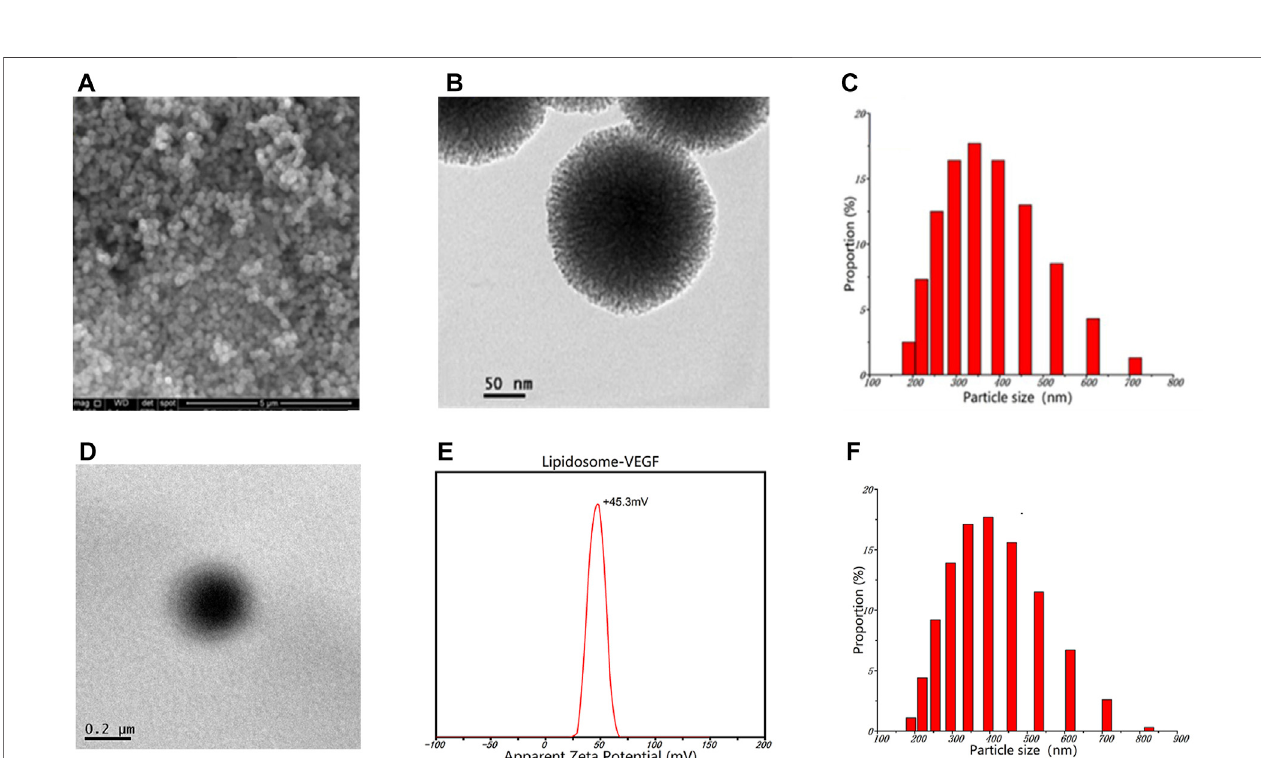
FIGURE 2 | Characterization of G-MBGN and liposomes. (A) SEM observation of G-MBGN. Nanoparticles with relatively uniform sizes could be seen under a low magni fi cation view. (B) Distinguishable mesopore inside nanoparticles under TEM. (C) DLS study on the particle size of G-MBGN and the particle size was around 340 nm. (D) TEM observation of the liposome. (E) DLS study on the zeta potential of the liposome. (F) DLS study on the particle size of the liposome.